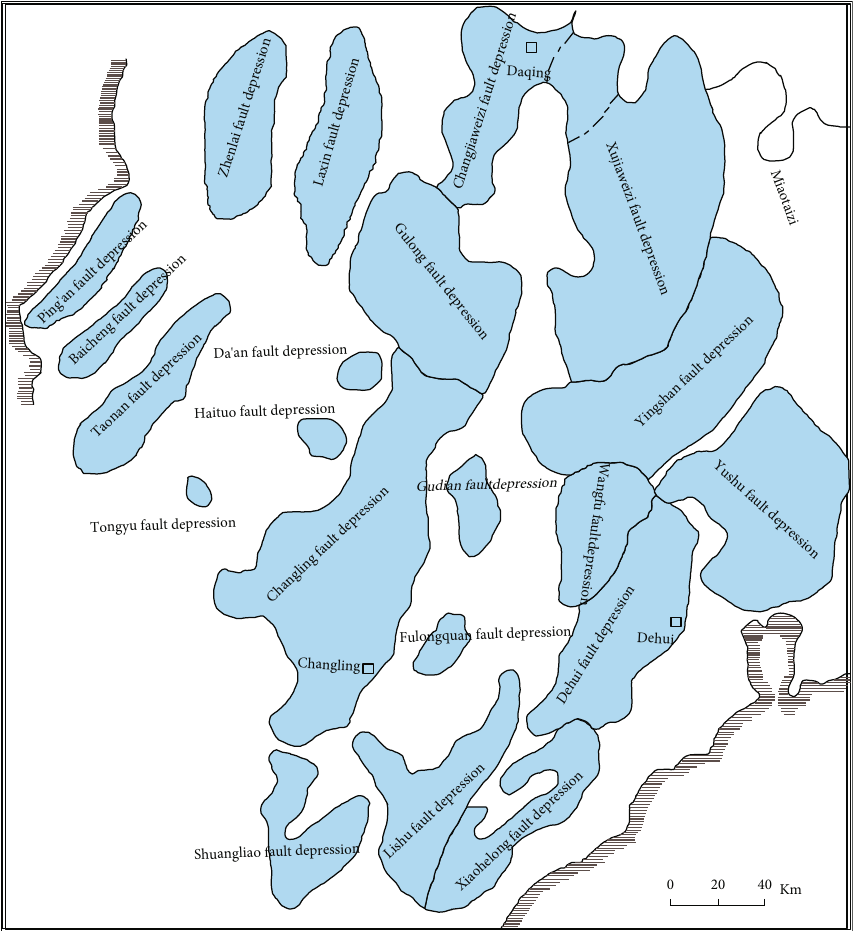
Figure 1: Map showing the distribution of main fault depressions in the southern Songliao Basin